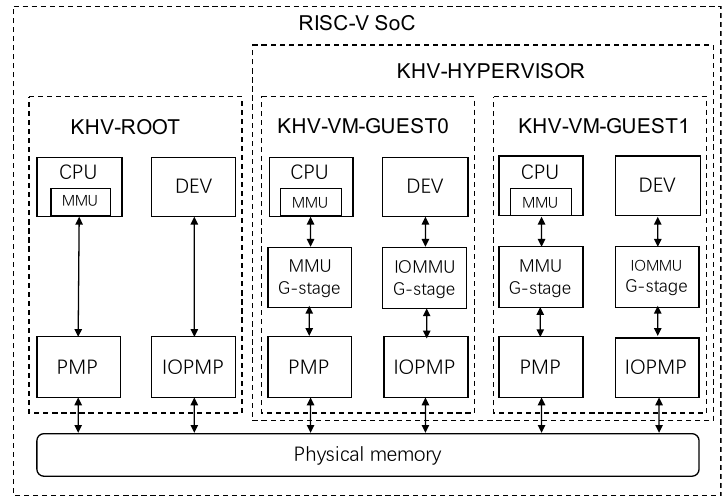
Figure 7. KHV-HYPERVISOR in a SoC.